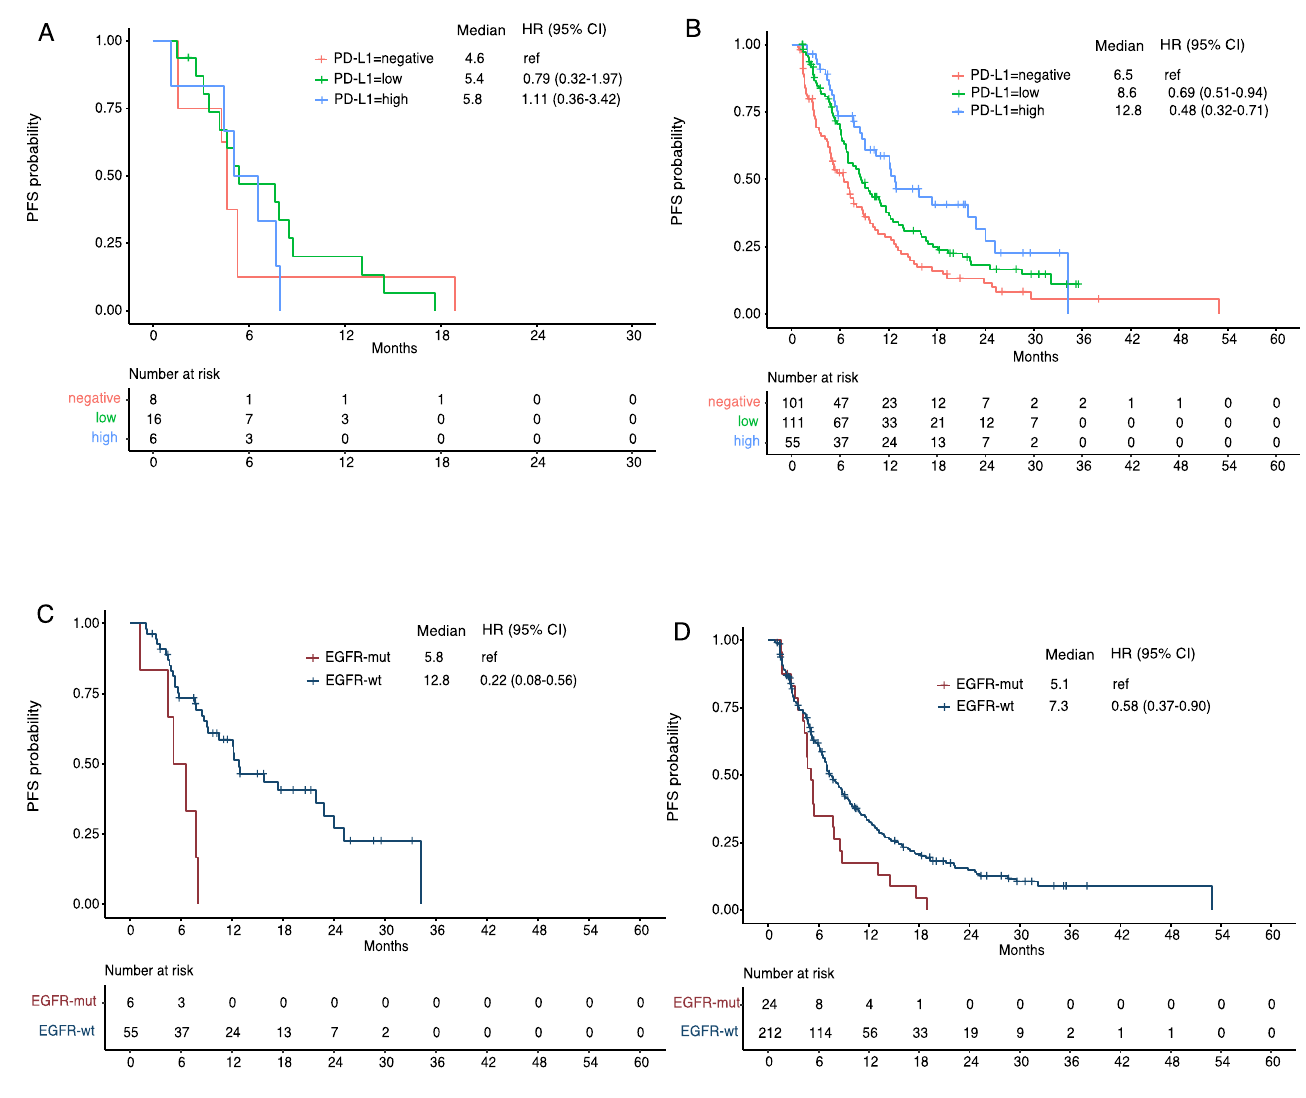
Figure 2. Progression-free survival (PFS) in lung adenocarcinoma patients with EGFR mutant (EGFR-mut) or EGFR wild type (EGFR-wt) who received chemotherapy-based immunotherapy as first-line. ( A ) PFS in EGFR-mutant patients stratified by PD-L1 level; ( B ) PFS in EGFR-wt patients stratified by PD-L1 level; ( C ) PFS in patients with high PD-L1 (TPS = 50–100%) between EGFR-mut and EGFR-wt; ( D ) PFS in patients with low or negative (TPS = 0–49%) PD-L1 level between EGFR-mut and EGFR-wt.